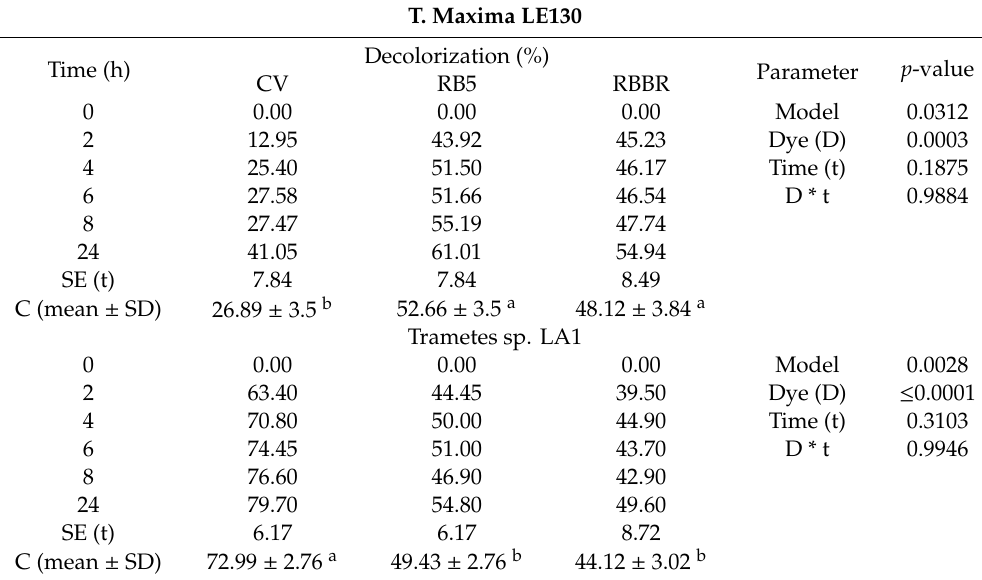
Table 3. Decolorization of dyes by liquid cultures of T. maxima LE130 and Trametes sp. LA1 grown in BRM medium at 28 ◦ C. Decolorization was investigated by adding 200 ppm of either the anthraquinonic dye RBBR, the azoic RB5 or the triphenylmethane CV to 18 day cultures of the evaluated